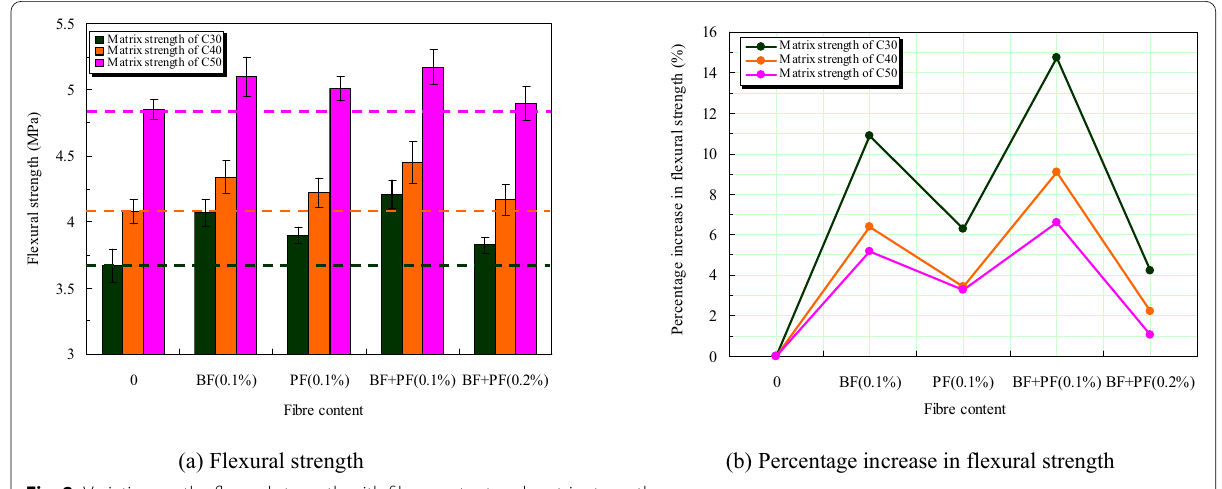
Fig. 8 Variation on the flexural strength with fiber content and matrix